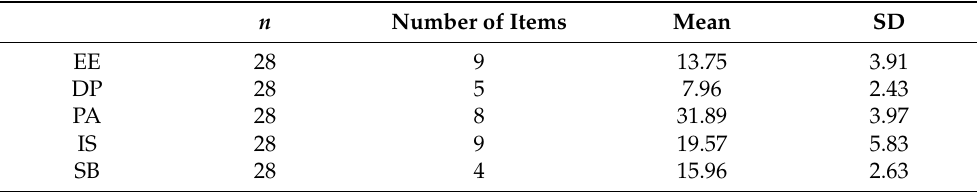
Table 2. MBI, IS, and SB